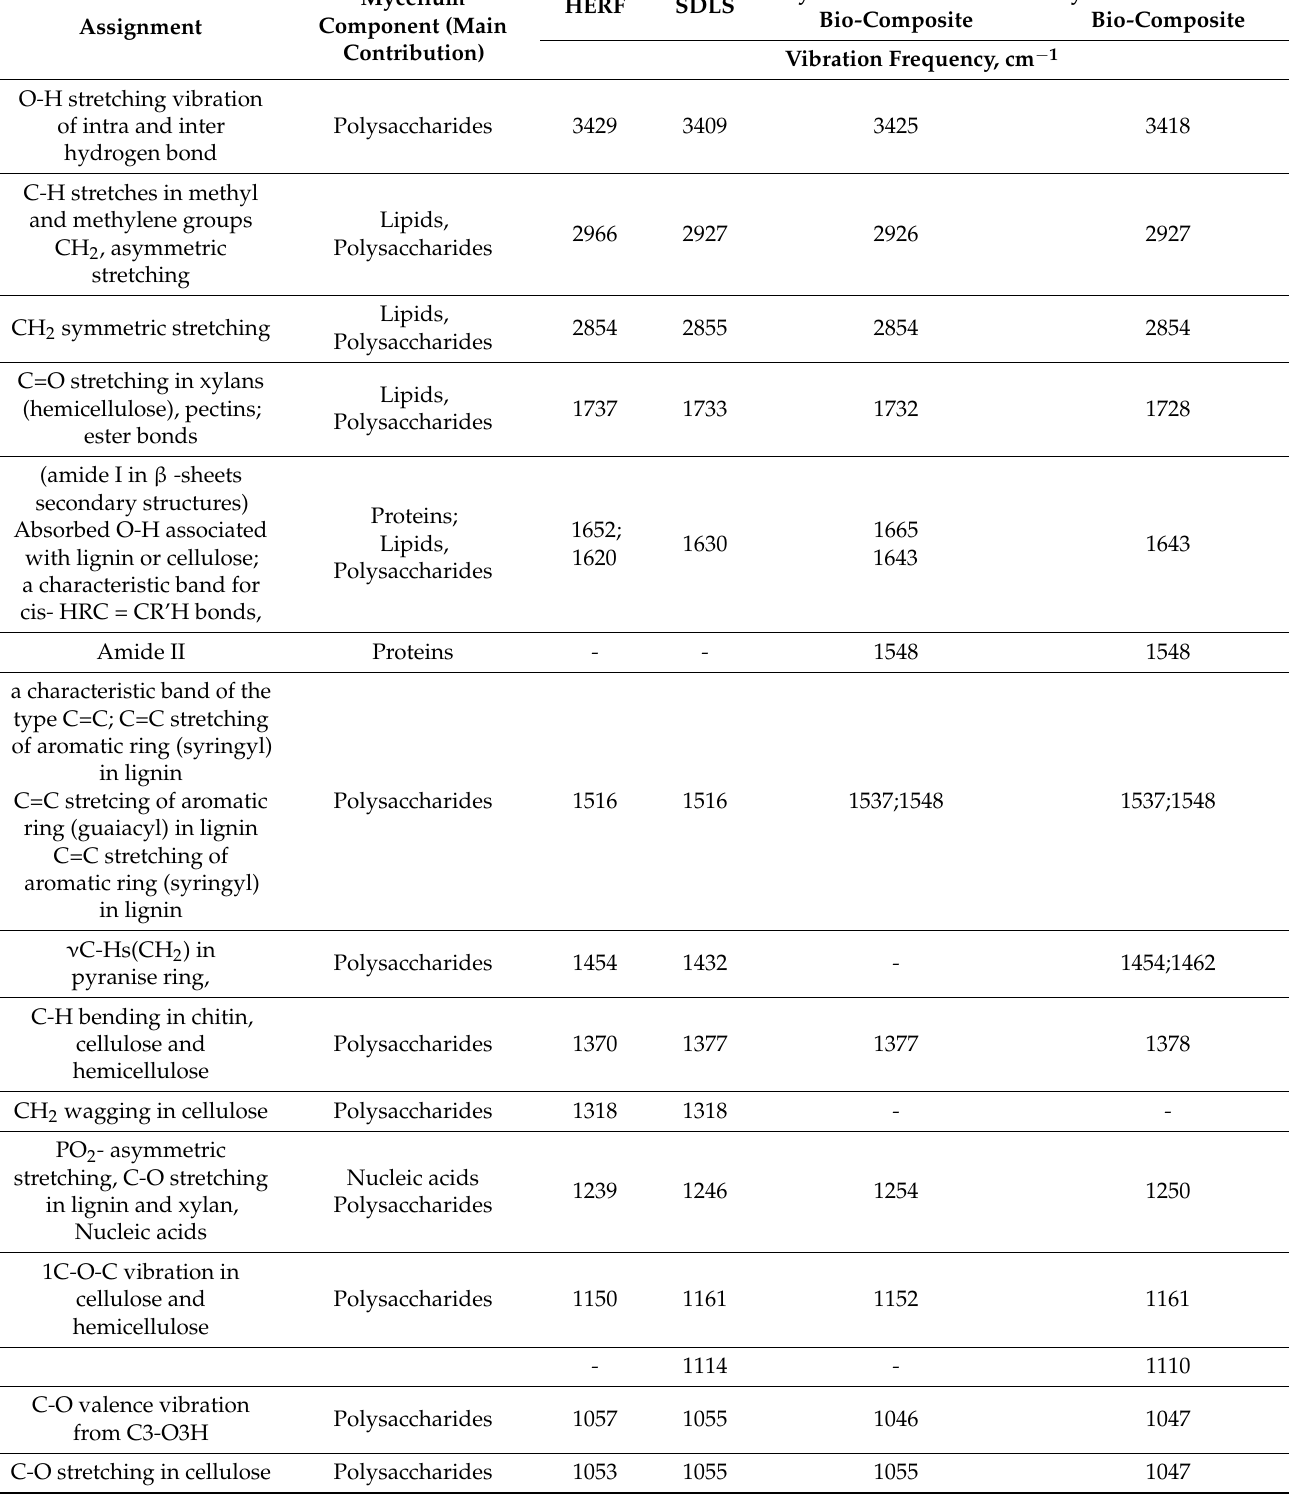
Table 4. Bands assignment for the FTIR characterization of hexane extracted rose flowers (HERF), steam distilled lavender straw (SDLS) and mycelium HERF/SDLS - based bio -